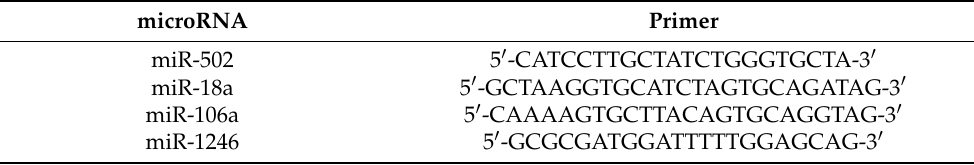
Table 3. Primers used for real-time PCR.